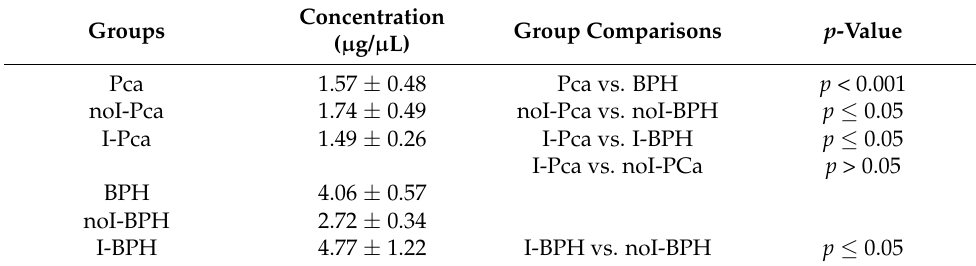
Table 2. Protein concentration of urinary